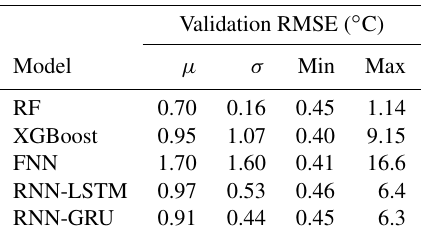
Table 6. Validation RMSE means µ , standard deviations σ , and maxima and minima for all model types resulting from hyperpa- rameter